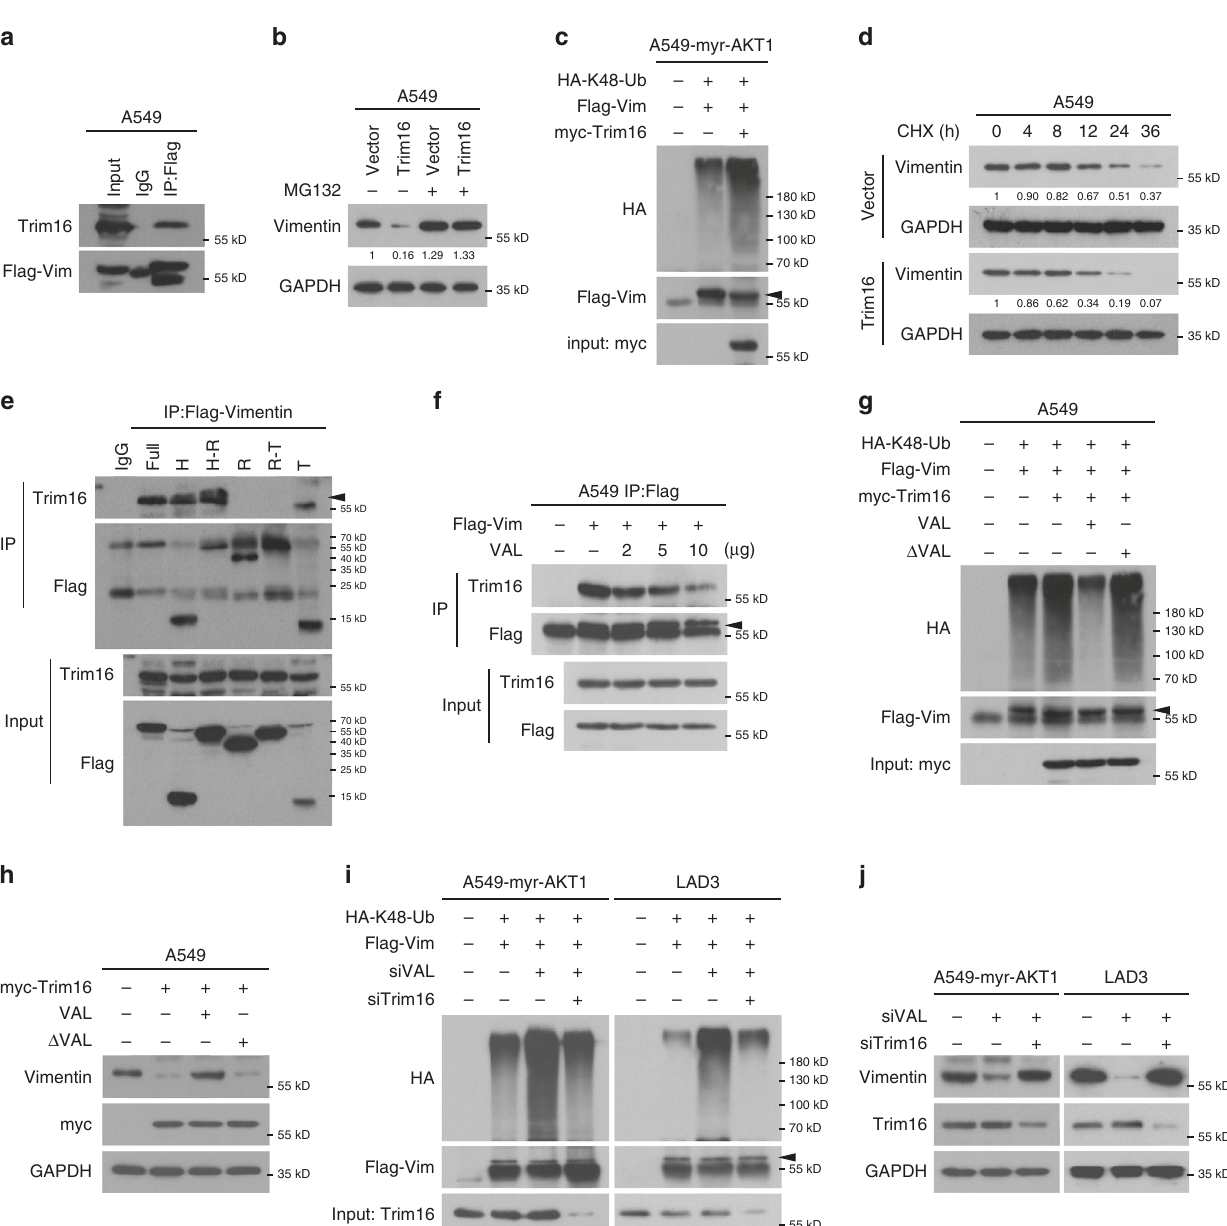
and masked for low-complexity or low-quality sequence, then mapped to HG38 whole genome using Bowtie2 version 2.3.5. Reads Per Kilobase of exon per Megabase of library size values were calculated using HTseq version 0.11.2. Sequencing data have been deposited in GEO database with accession number GSE136904.